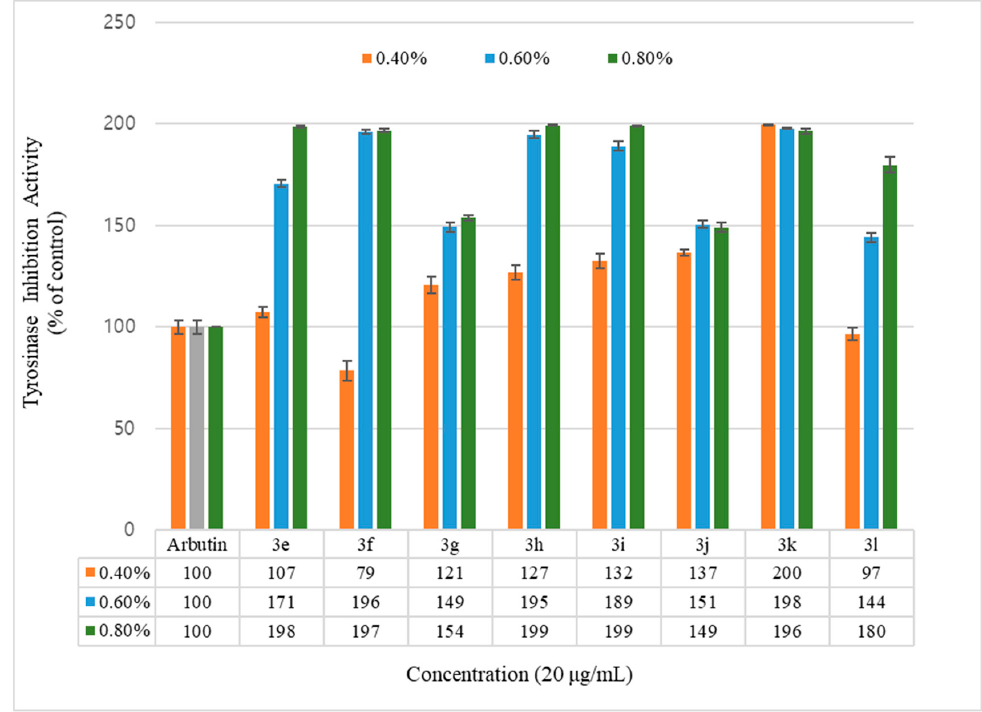
Figure 3. Mushroom tyrosinase activity effects of geranyloxycoumarin derivatives and reference. Results are expressed as means ± SEMs.